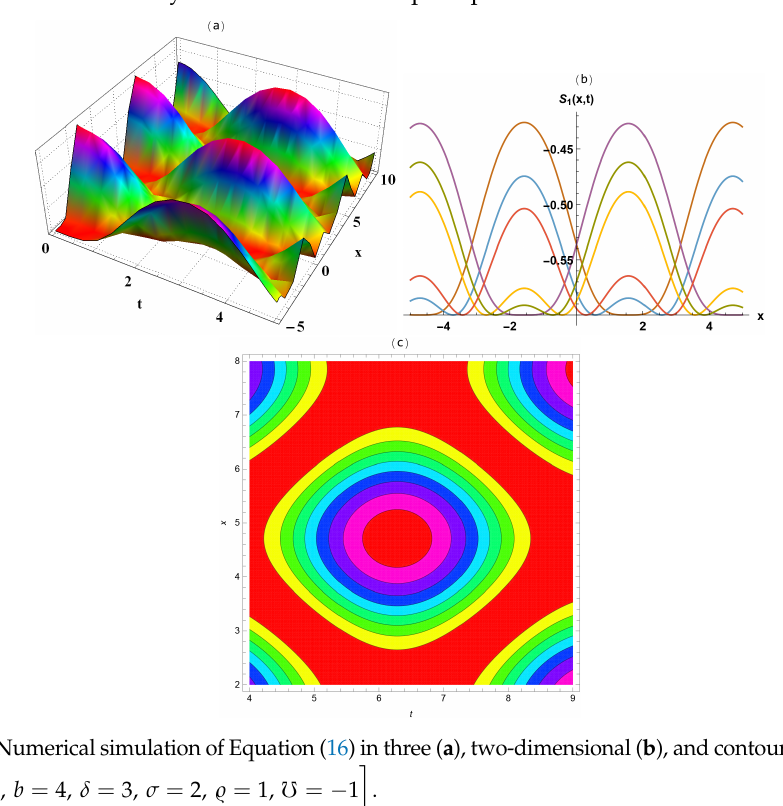
(cid:21) = − 1 . (cid:48)